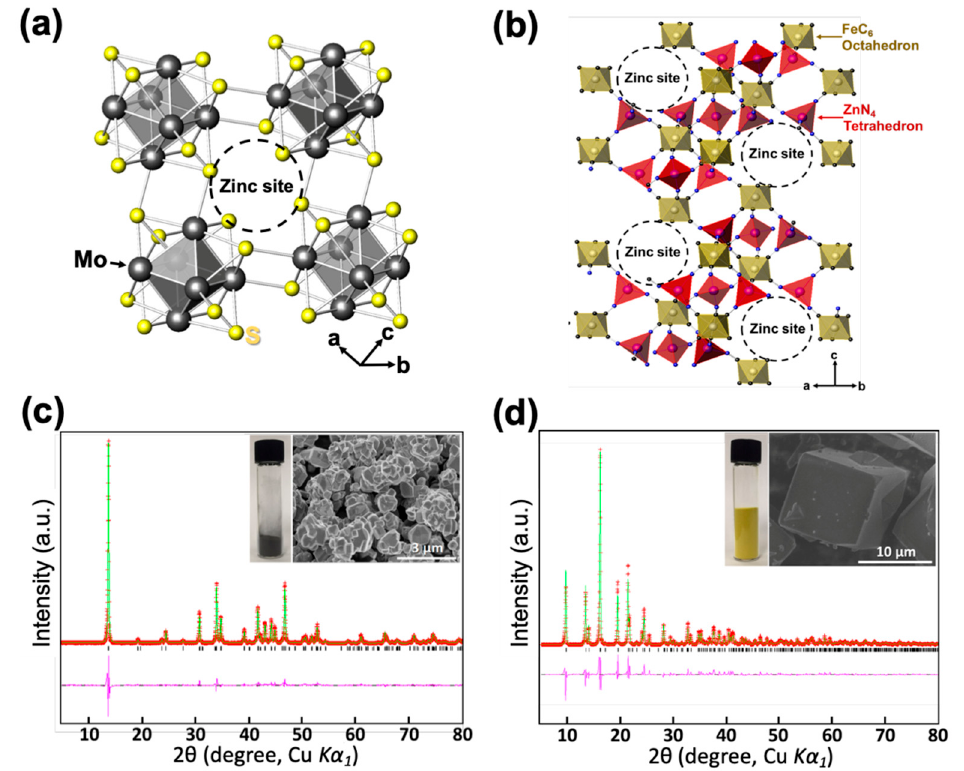
Figure 1. ( a ) The crystal structure of the Chevrel phase, Mo 6 S 8 . ( b ) The crystal structure of zinc hexacyanoferrate (ZPB). ( c ) Powder X-ray Rietveld refinement profile for Mo 6 S 8 at 25 °C, and an SEM image of the powder. ( d ) Powder X-ray Rietveld refinement profile for the ZPB at 25 °C, and an SEM image of the particles (red points: experimental data; green line: calculated data; pink line: difference; black bars: Bragg positions).